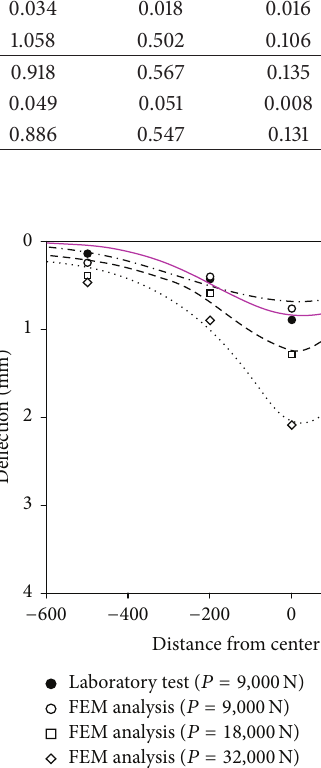
Figure 5: Comparison of deflection from the analysis and test (basket weave).